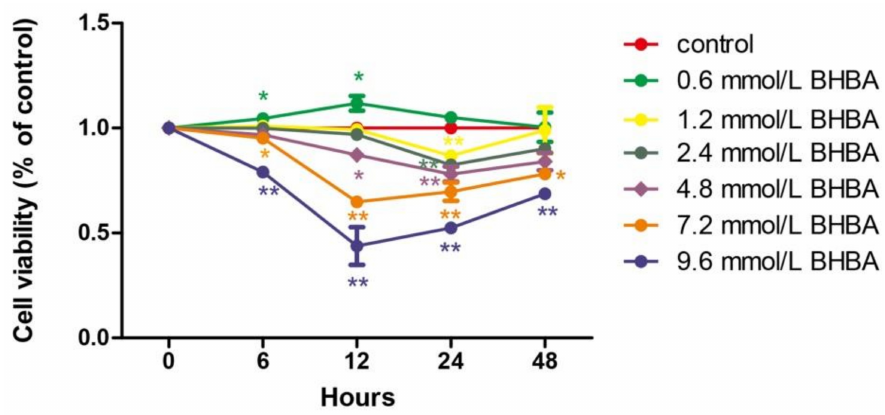
Figure 1. The effect of different of times and β -hydroxybutyrate ( BHBA ) concentrations on the relative viability of bovine endometrial (BEND) cells. * p < 0.05 vs. control group, ** p < 0.01 vs. control group.